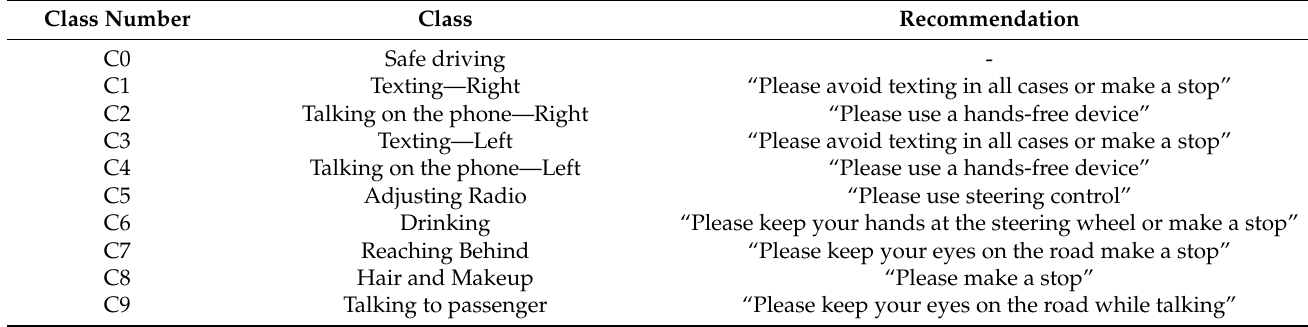
Table 2. Recommendations for distracted drivers.